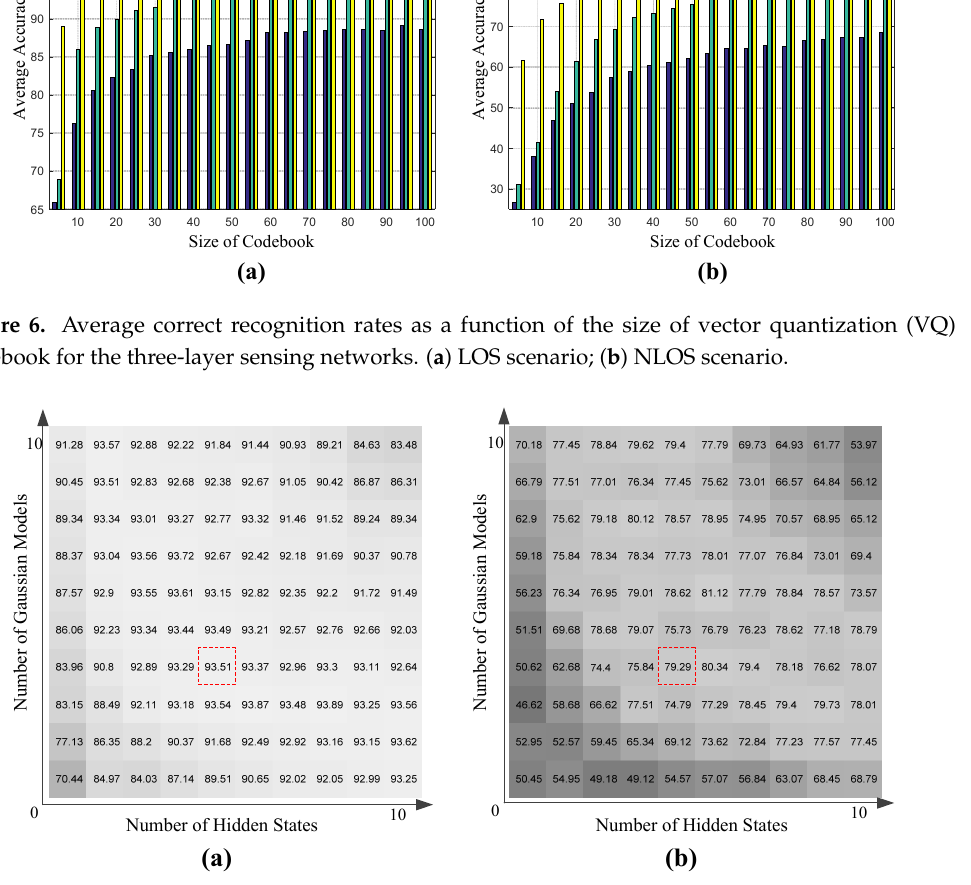
Figure 7. Average correct recognition rates as a function of the number of hidden states and Gaussian models in hidden Markov model (HMM). ( a ) LOS scenario; ( b ) NLOS